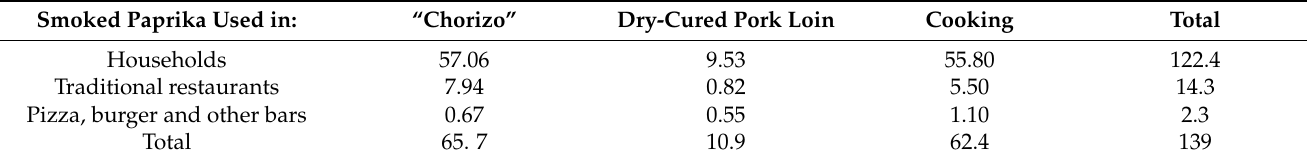
Table 3. Total intake per person of smoked paprika in Extremadura in households and restaurants (g person − 1 year − 1 ). Smoked Paprika Used in: “Chorizo” Dry-Cured Pork Loin Cooking Total Households Traditional restaurants